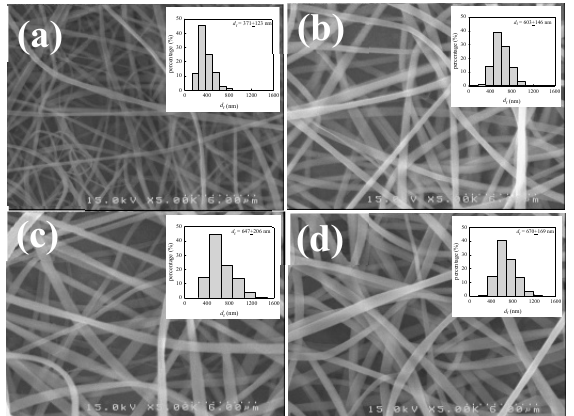
Figure 14. SEM images and diameter distributions of a-PNIPAM fibers electrospun at a given flow-rate of ( a ) 0.05, ( b ) 0.1, ( c ) 0.15 and ( d ) 0.2 mL/h. (12 wt% solution, V = 17 kV, H = 21 cm, T solution = 10 ºC.).